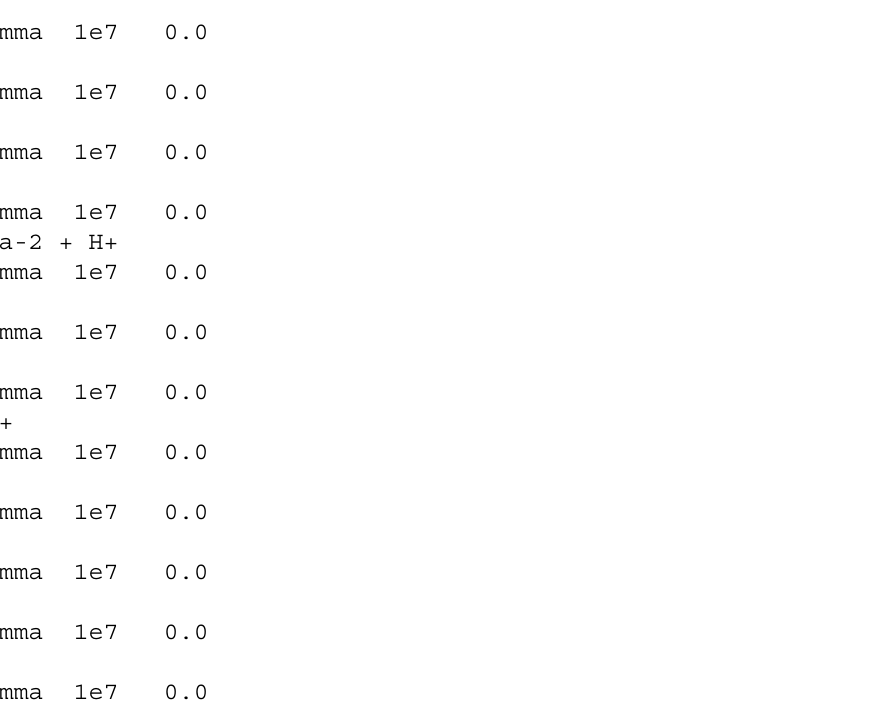
Table 39. Database for example